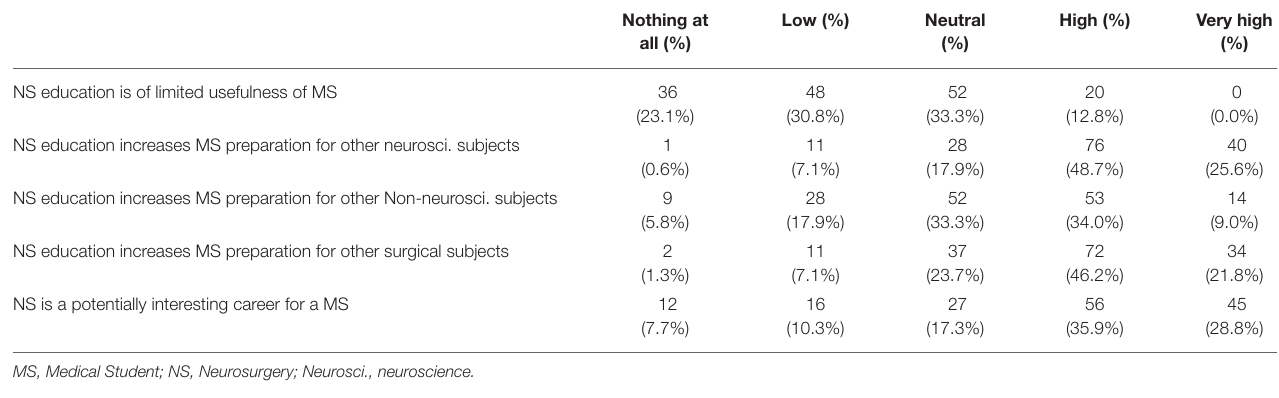
Nothing at Low (%) Neutral all (%)